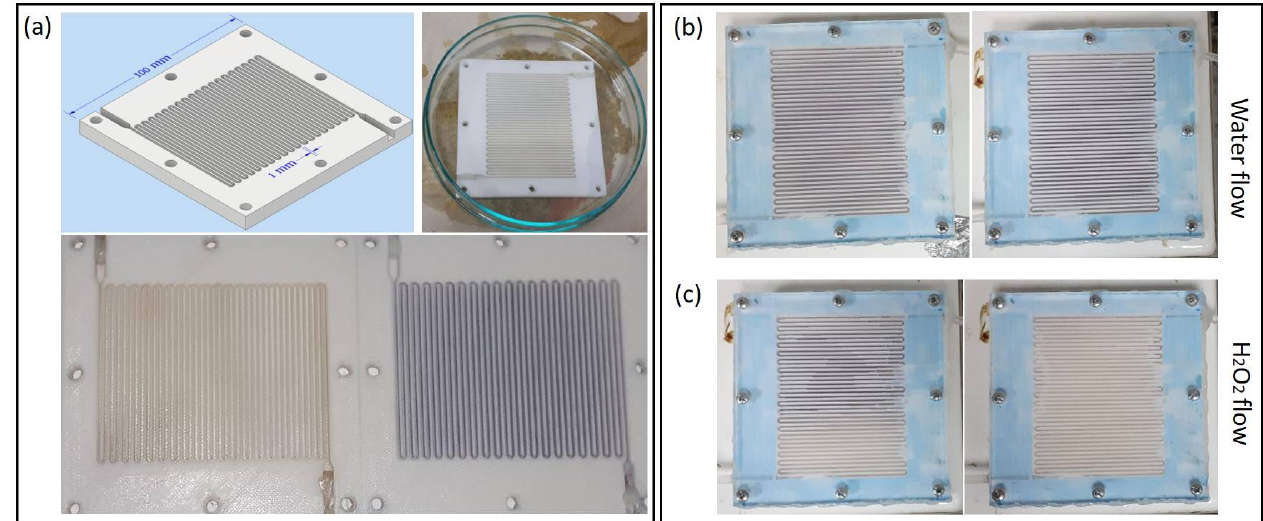
Figure 4. ( a ) Top-left: CAD design of 3D-printed milli-reactor, Top-right: impregnation process of 3D-printed milli-reactor, Bottom: 3D-printed milli-reactors impregnated with spherical AgNPs (yellow hue) and non-spherical AgNPs (blue hue), respectively. ( b ) Image of impregnated 3D-printed PLA milli-reactors before ( left ) and after ( right ) long-time water stream. ( c ) Image of impregnated 3D-printed PLA milli-reactors before ( left ) and after ( right ) hydrogen peroxide stream.